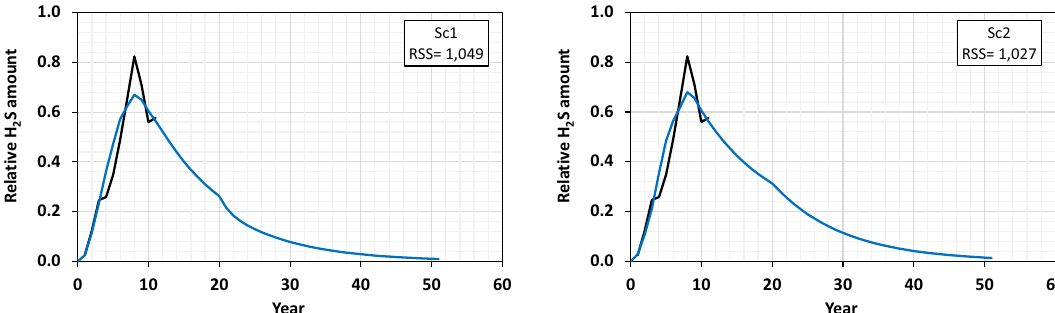
Fig. 4 Measured (black line) and modeled (blue line) total H 2 S generation of scenarios 1 and 2 in relative values due to data